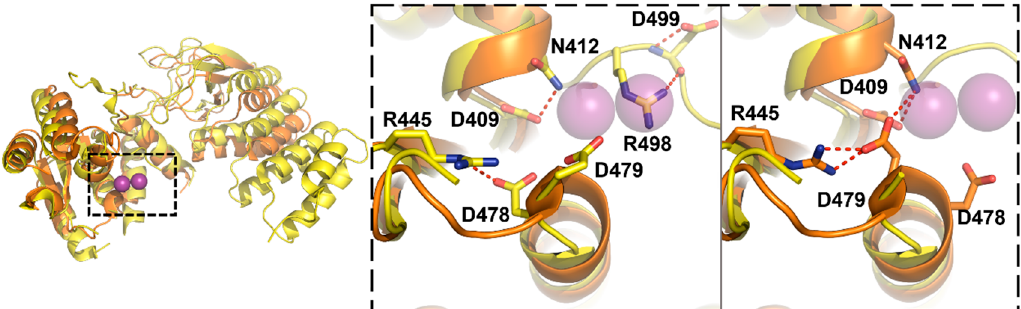
Figure 6. Alignment of two MRPP3 structures (PDB 4xgl, yellow; PDB 4rou, orange) with the At PRORP1 active site (PDB 4g24, only metal ions shown) [66,69,107]. Left : Alignment of two MRPP3 structures with the PRORP1 active site (purple spheres). MRPP3 NYN residues (4xgl: S361/P362, D409, D479, and D499, or 4rou: residues S361/P362, D409, D478, and D479) were aligned to the equivalent PRORP1 residues. The dashed box is expanded on the right. Middle and Right panels: Dashed box contains the aligned MRPP3 active site residues from 4xgl (middle, yellow) or 4rou (right, orange) with Mn 2+ from PRORP1 (transparent purple spheres). Residues with the potential to occlude the metal sites, N412, R445, and R498, are shown if coordinates are available. Hydrogen bonds between residues are shown as dashed red lines.